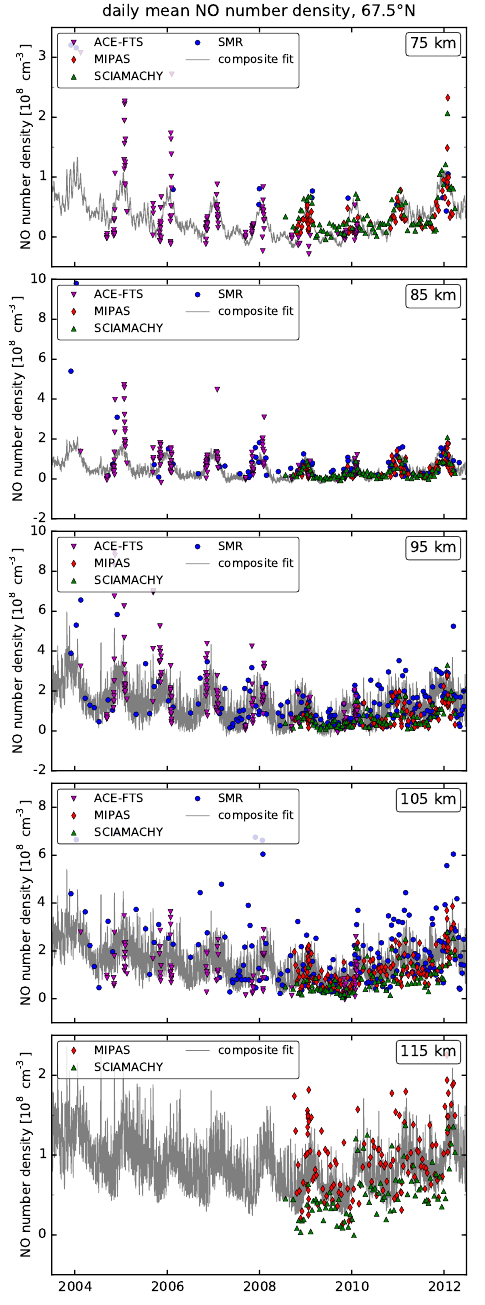
Figure C1. NO time series regression results at 67.5 ◦ N, for 75km, 85km, 95km, 105km, and 115km (from top to bottom).